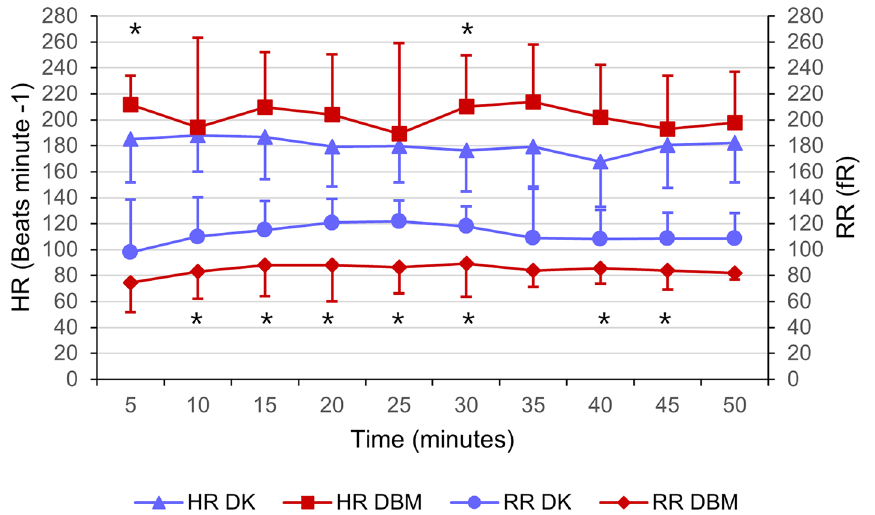
Figure 2. Heart rate (HR) and respiratory rate (RR) in 20 Egyptian fruit bats during general anaesthesia for gonadectomy. Bats in group DK (n = 10) received DEX and KET combination and bats in group DBM (n =